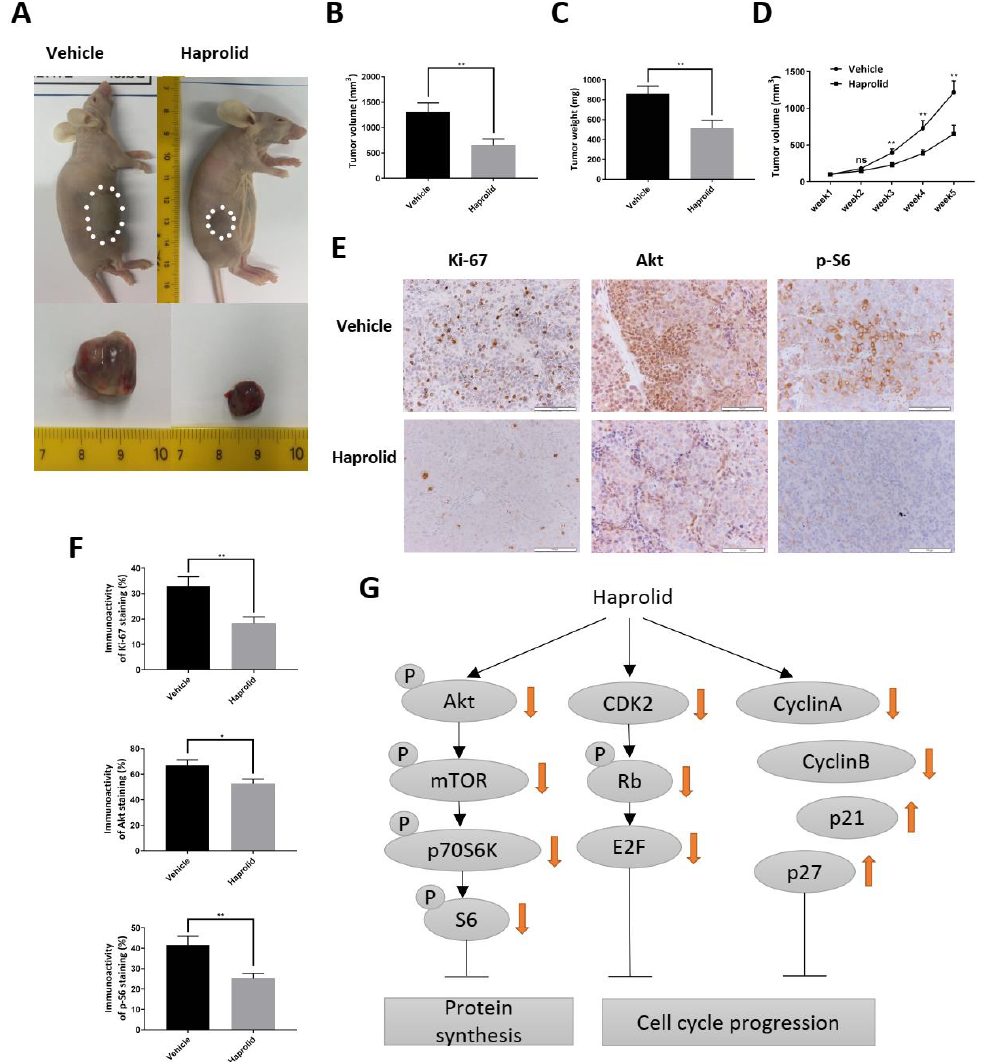
Figure 7. Effect of haprolid on mice bearing Hep3B xenograft tumors. ( A ) Representative image of tumors in control and haprolid-treated (2 mg/kg body weight) mice. Dotted lines sketch out tumors in the flanks. ( B and C ) Mean tumor volume and weight in control and haprolid-treated mouse groups ( n ≥ 5 per group). ( D ) Tumor growth curves. ( E ) Tumor tissue sections were stained with Ki67, Akt and p-S6. Representative IHC staining images were taken at 200× magnification. Scale bars: 100 µm. ( F ) Immunostaining activity of Ki67, Akt and p-S6 was scored and plotted in bar graph. ( G ) The schematic diagram showing the function and mechanism of haprolid in HCC. Data represent means ± SEM of at least three independent experiments. * p < 0.05, ** p < 0.01, *** p < 0.001, **** p <